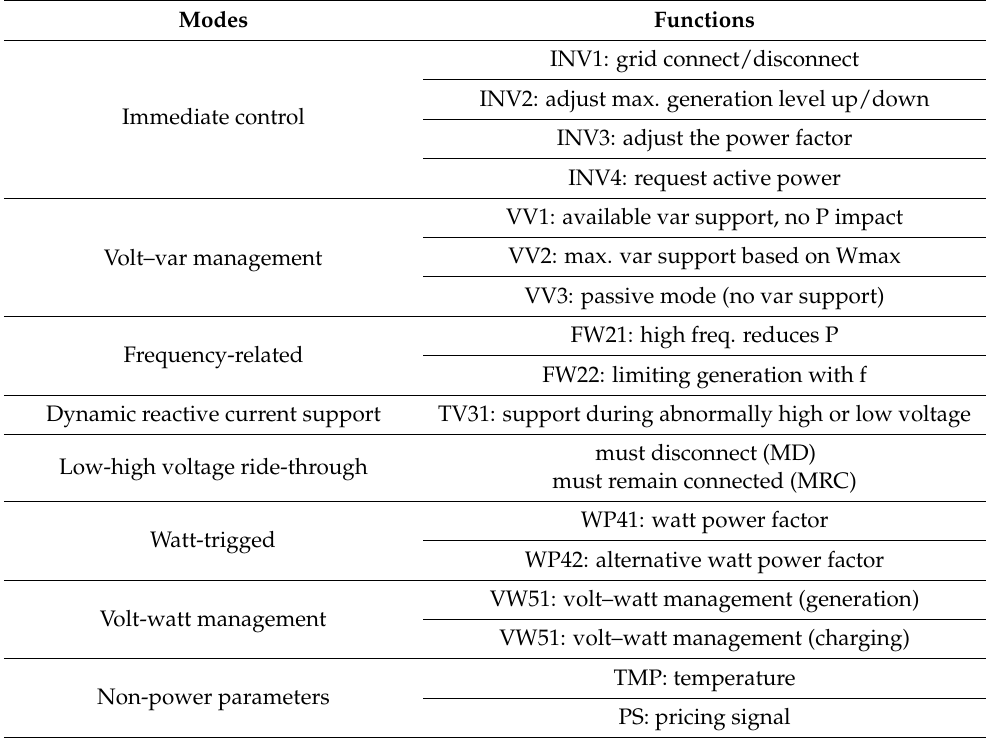
Table 2. Smart inverter applications covered by IEC61850-90-7